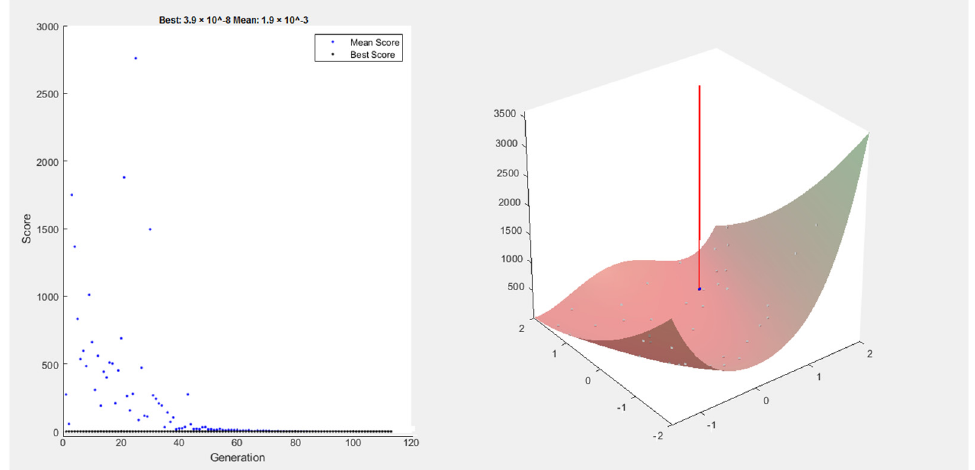
Figure 8. Selecting the global and local best values with the mean score.